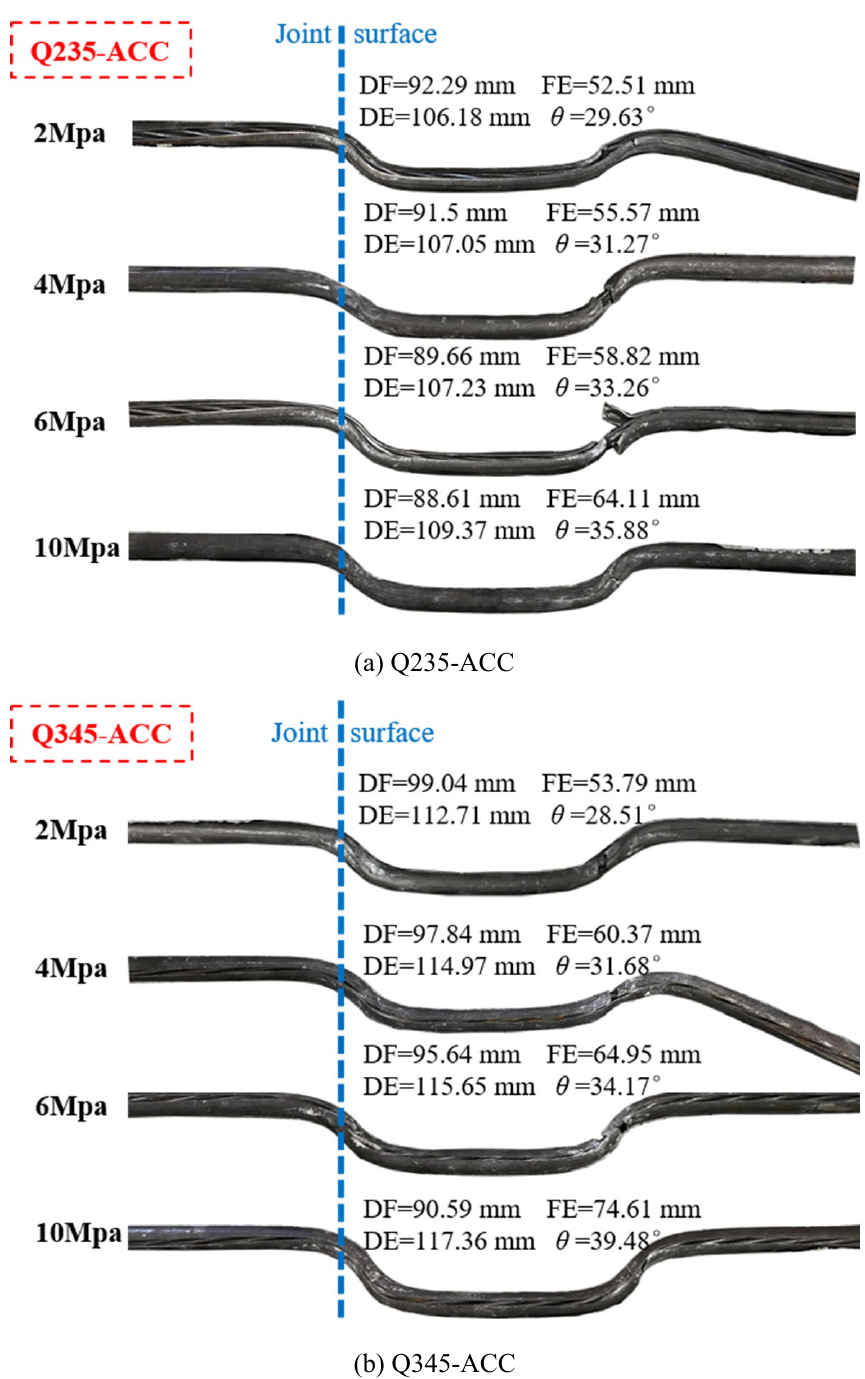
Figure 7. Photographs of the ACC failures and